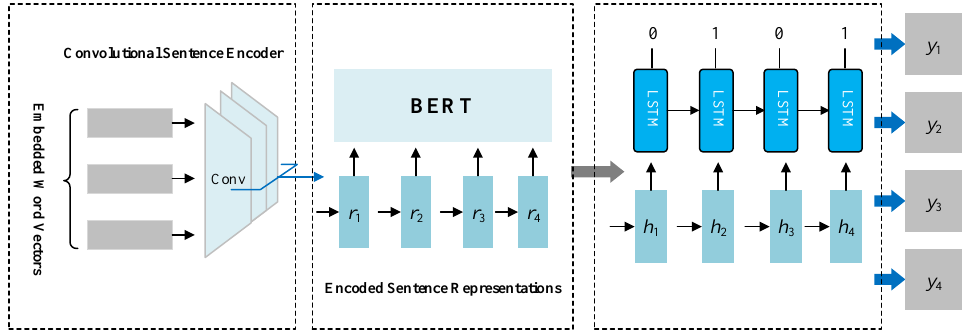
Figure 3. The overview of the extractive model. First, we employed a temporal convolutional model to compute the representation of each individual sentence in the document. Then, we annotated the sequence of the sentence vectors to indicate whether the extractive summary should contain the corresponding sentences, in order to realize the extraction of key